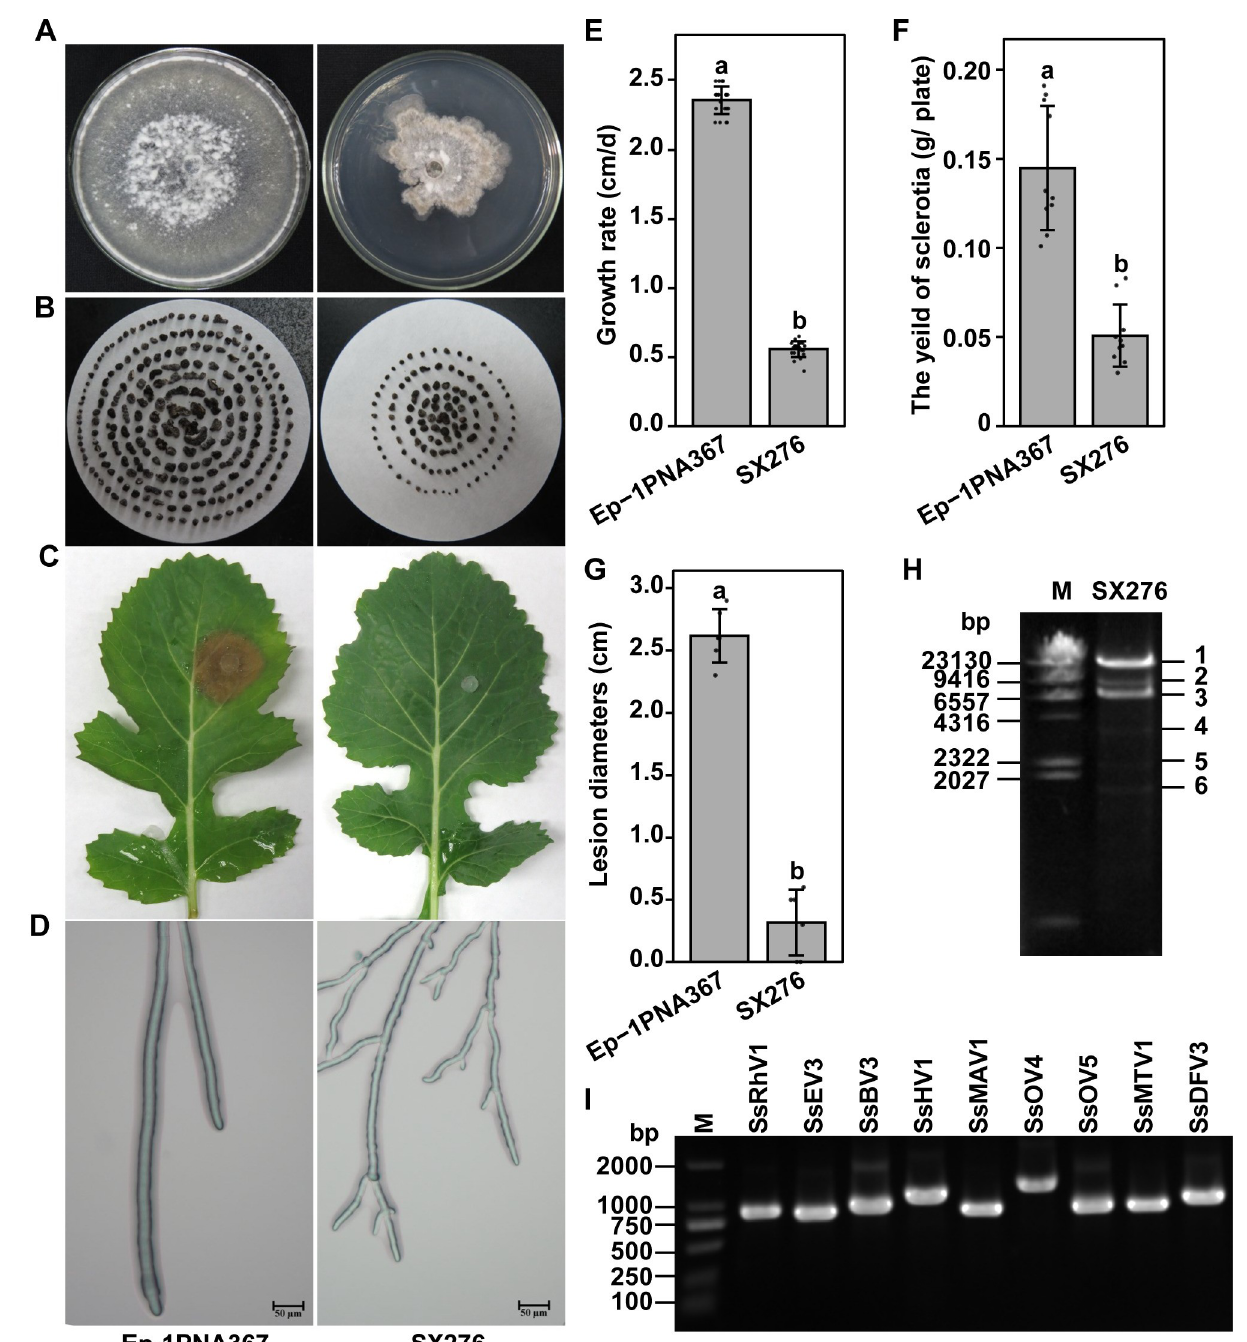
Fig 1. S . sclerotiorum strain SX276 shows hypovirulent phenotypes. (A) Colony morphology of strains Ep-1PNA367 and SX276. All strains were cultured on PDA plates for 7 days prior to photography. (B) Sclerotia of strains Ep-1PNA367 and SX276. Sclerotia from ten PDA plates of each strain were collected and photographed together. (C) Pathogenicity assay of strains Ep-1PNA367 and SX276 were carried out on detached leaves. Photos and data were taken at 48 hours post-inoculation. (D) Hyphal tips of strains Ep-1PNA367 and SX276. (E) Growth rate of strains Ep-1PNA367 and SX276 under laboratory conditions at 20˚C. (F) The yield of strains Ep-1PNA367 and SX276. (G) Lesion diameters induced by the two strains on detached rapeseed leaves (20˚C, 48 hours post-inoculation). (H) Agarose gel electrophoresis of the dsRNA elements associated with strain SX276. (I) RT-PCR confirmation of de novo assembled contigs from strain SX276 generated by Illumina sequencing. Lane M: DL2000 DNA molecular weight Marker (Takara Dalian, China); lane 1 to 9: abbreviations of viruses (see Table 1 for detail). Error bars indicate the SD from six sample means. The different letters on the top of each column indicate significantly difference at the P < 0.05 level of confidence according to the t test.